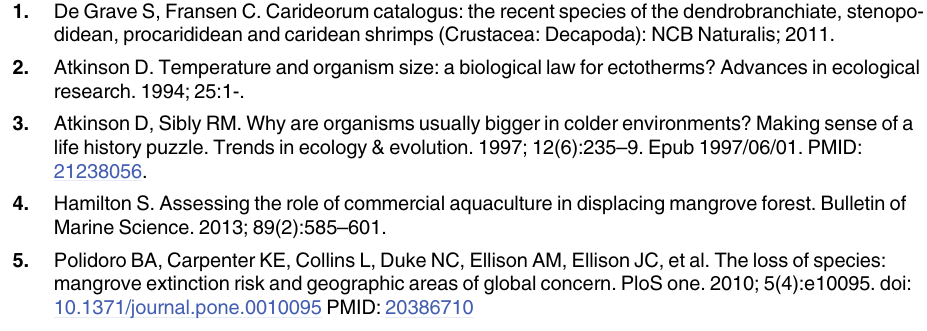
S1 Table. Major clades from combined data parsimony analysis. (PDF) S2 Table. Synapomorphies of major clades in this study based on shortest parsimony trees. (PDF) S3 Table. Additional synapomorphies of crown clades with extinct sister taxa. (PDF) S4 Table. Global shrimp aquaculture production by species based on Food and Agriculture Organization of the United Nations (FAO) statistics (http://www.fao.org/fishery/statistics/ en). Italicized values are FAO estimates, and some zero (0) values may correspond to very small contributions, rounded to 0. Species names are as reported by FAO, with those that belong to Agripenaeina indicated in bold. S5 Table. Taxa sampled in the study and summary of data collected. (PDF) S6 Table. Age information and number of specimens sampled for fossil taxa in this study.